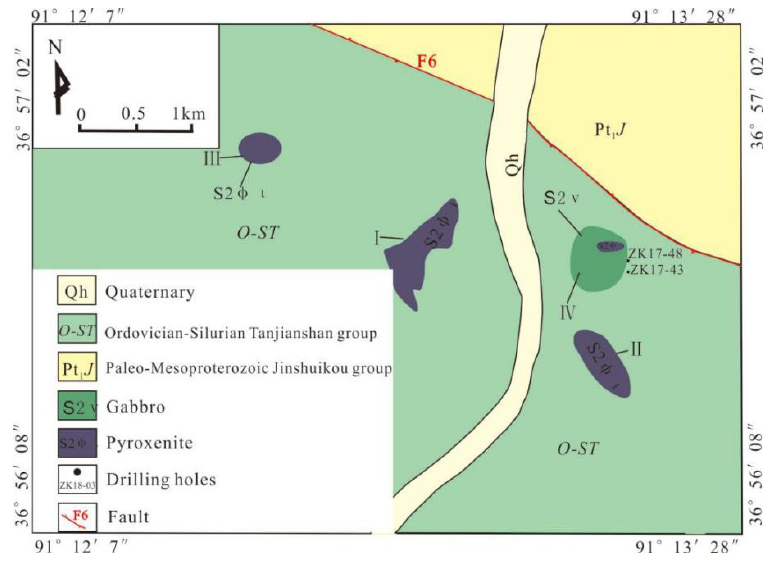
Figure 2. Geological sketch map of the Akechukesai ore district.